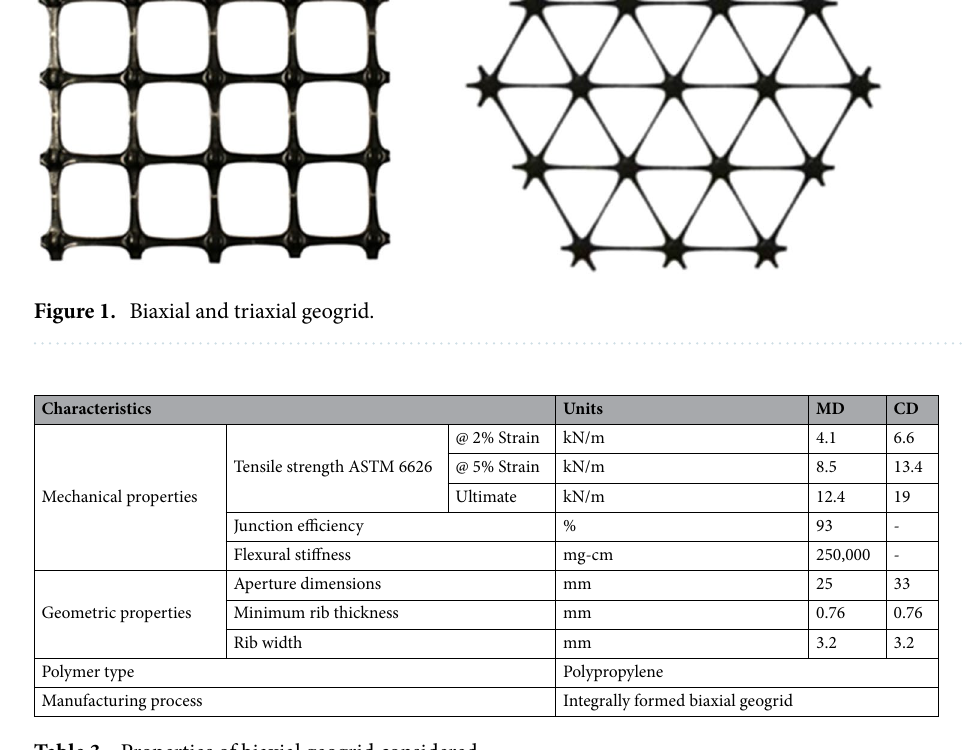
Table 3. Properties of biaxial geogrid